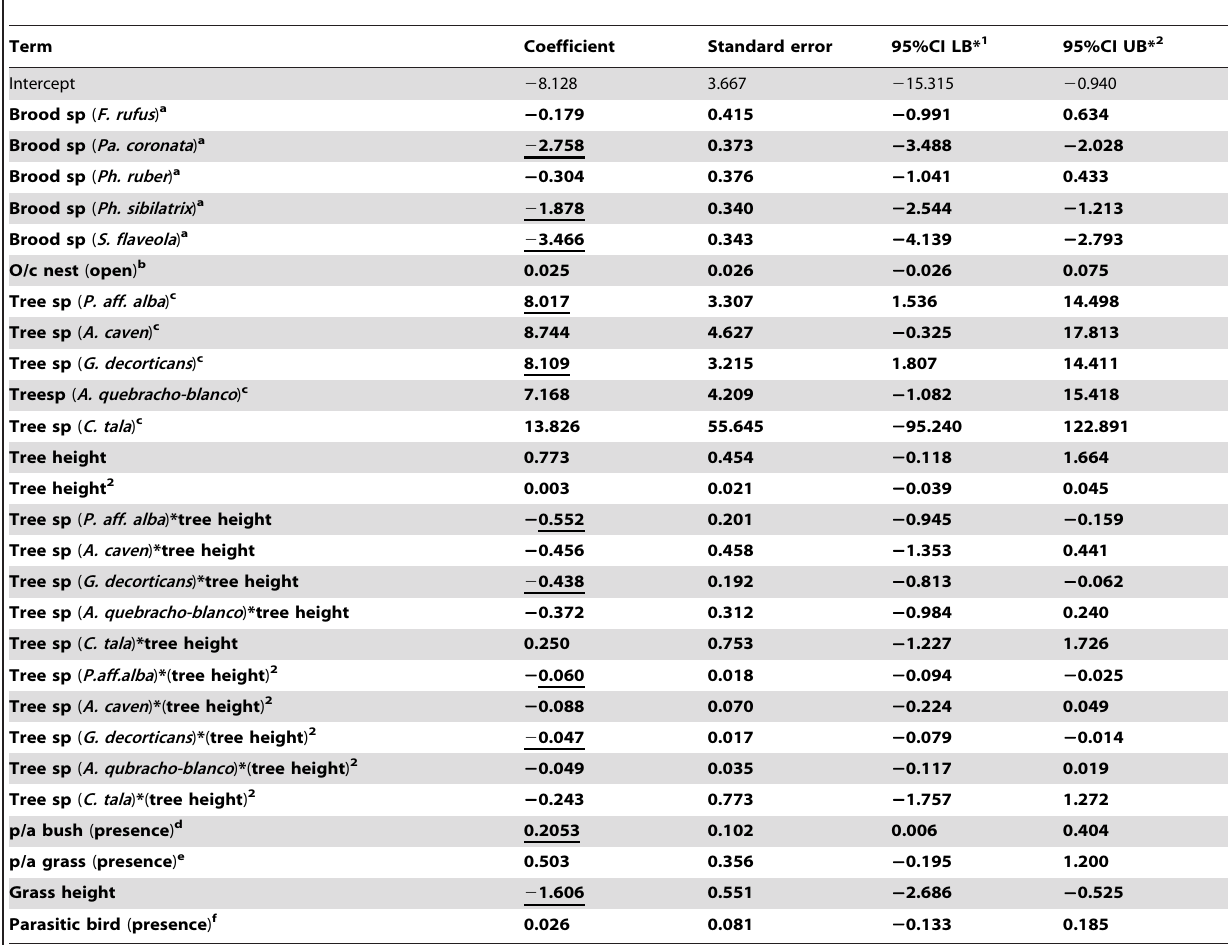
Table 3. Variables of interest of the best models describing microhabitat (nest and surrounding) factors associated with mean P. torquans abundance in a